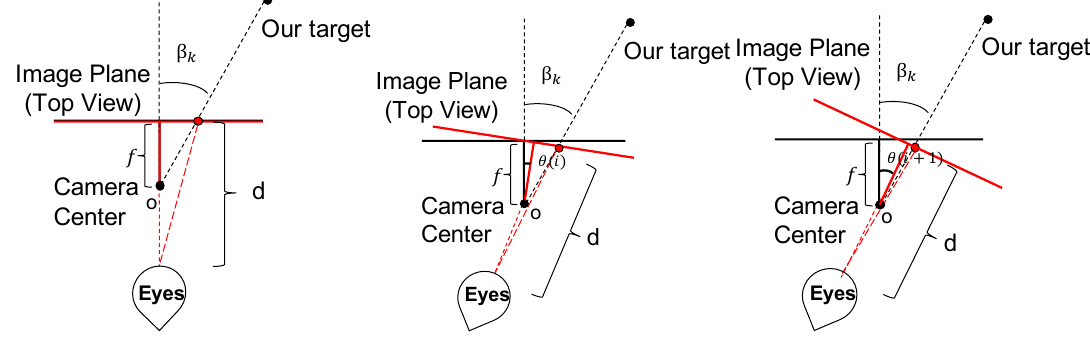
Figure 3. Images of target object under yaw motion from the top